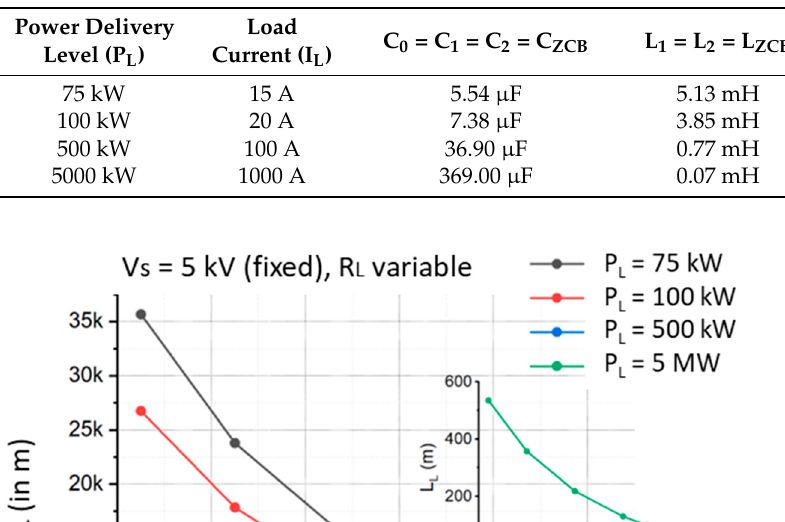
Table 4. Specification of ZCB parameters and fault bases according to power delivery levels.